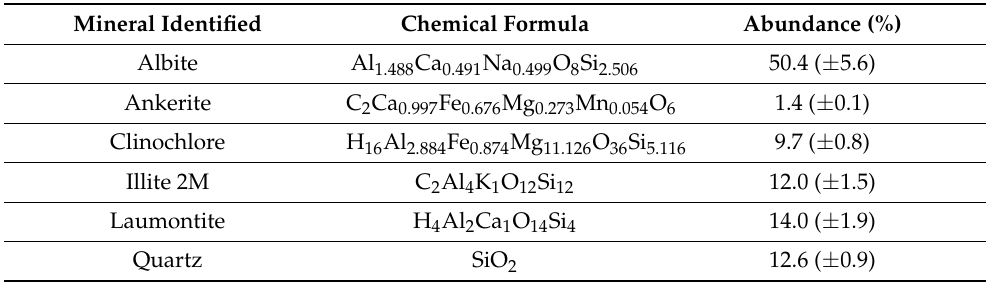
Table 1. XRD results of the mineral phases identified and their respective abundance percentages from a random selection of the